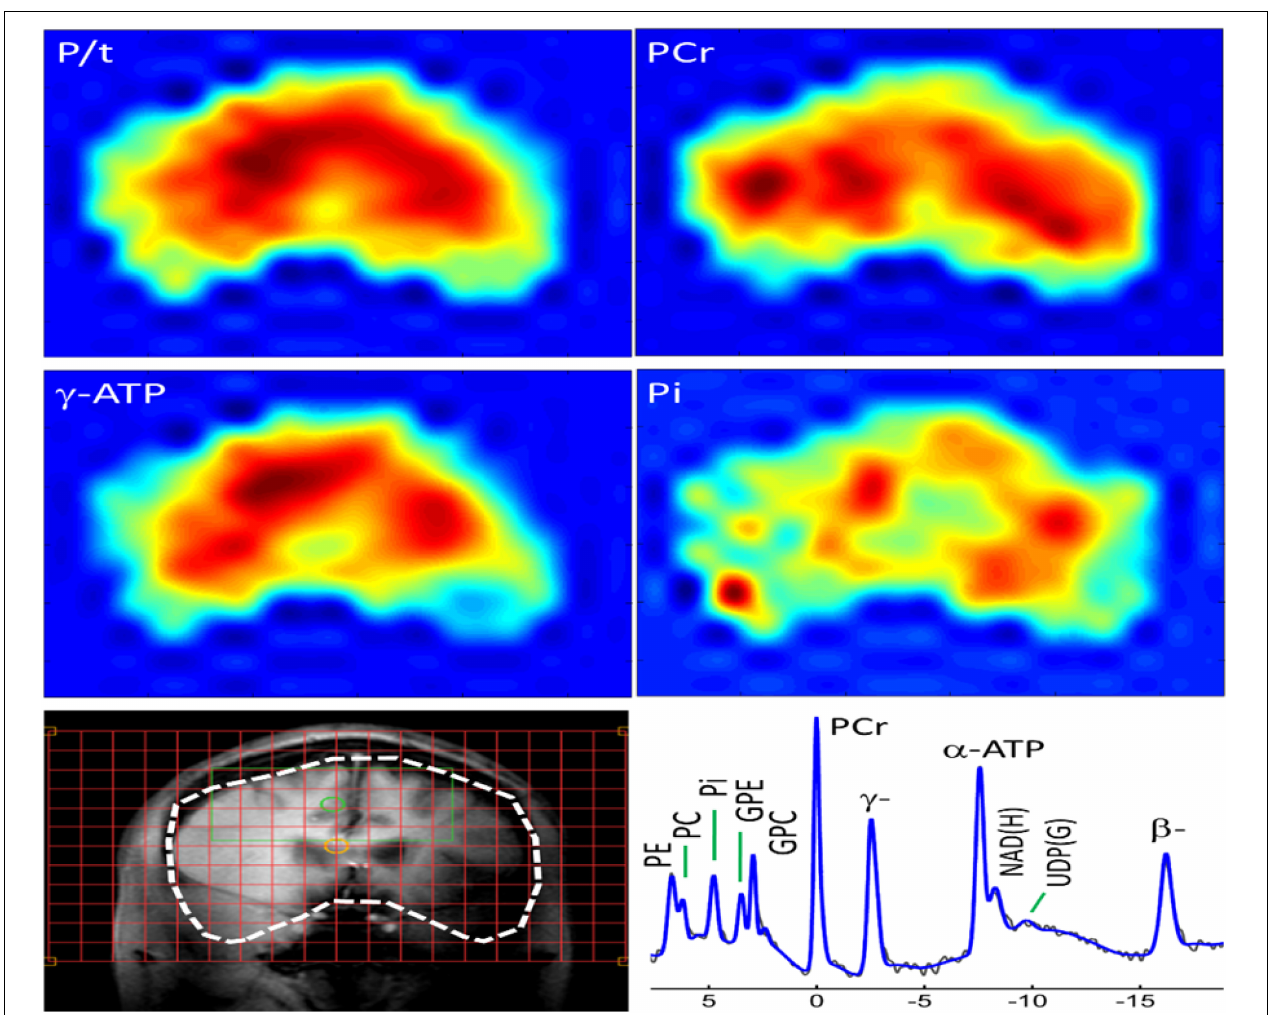
FIGURE 1 | Whole-brain 31 P MRS spectral displayed on coronal anatomical images. Total 31 P signal from all metabolites; Color maps show the spatial distribution of specific